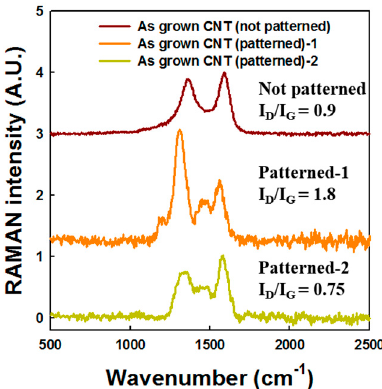
Figure 8. Normalized Raman spectra of patterned and non-patterned as-grown CNT samples. Raman spectra acquired with a 514 nm excitation laser.